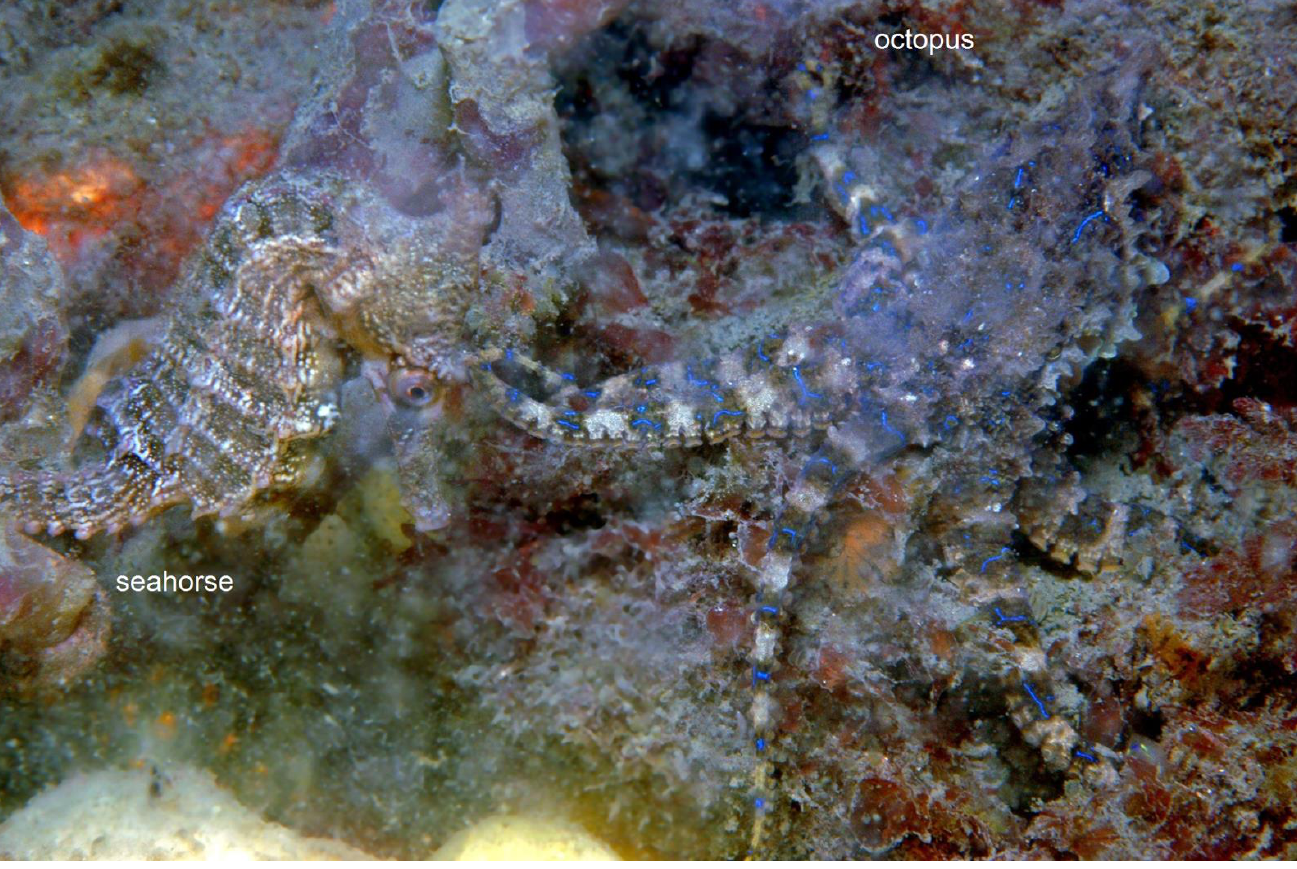
Figure 3. An individual of Hippocampus whitei nearly caught by a blue-lined octopus ( Hapalochlaena fasciata ) at Port Stephens, NSW, Australia. Both show camouflage. Photo credit: David Harasti.